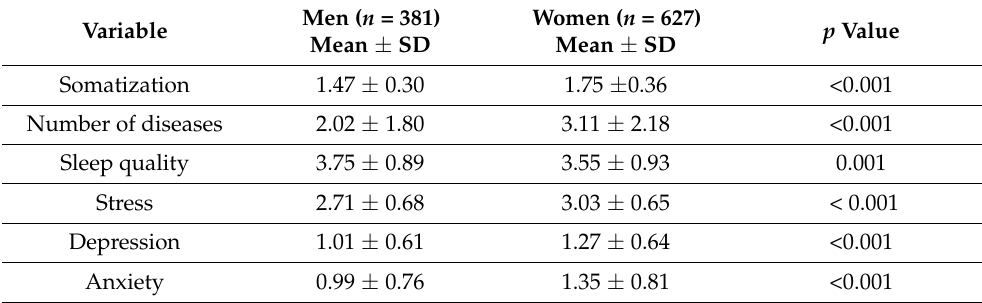
Table 3. Comparison of psychological variables and number of diseases between sexes.